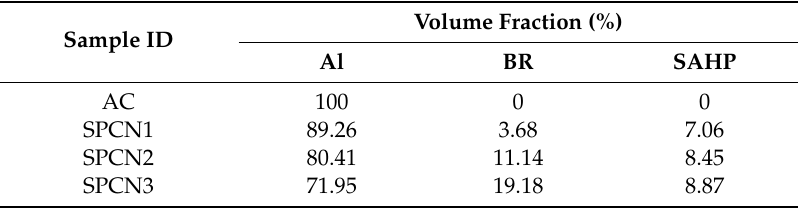
Table 2. Volume fraction (%) of phases formed onto the coating